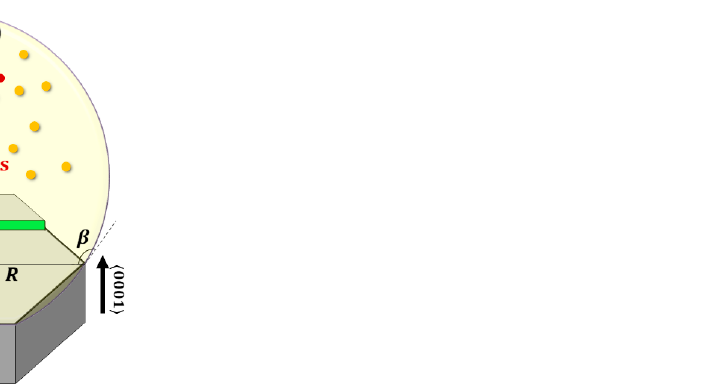
Table 1. Surface energies used for simulations of ML growth.